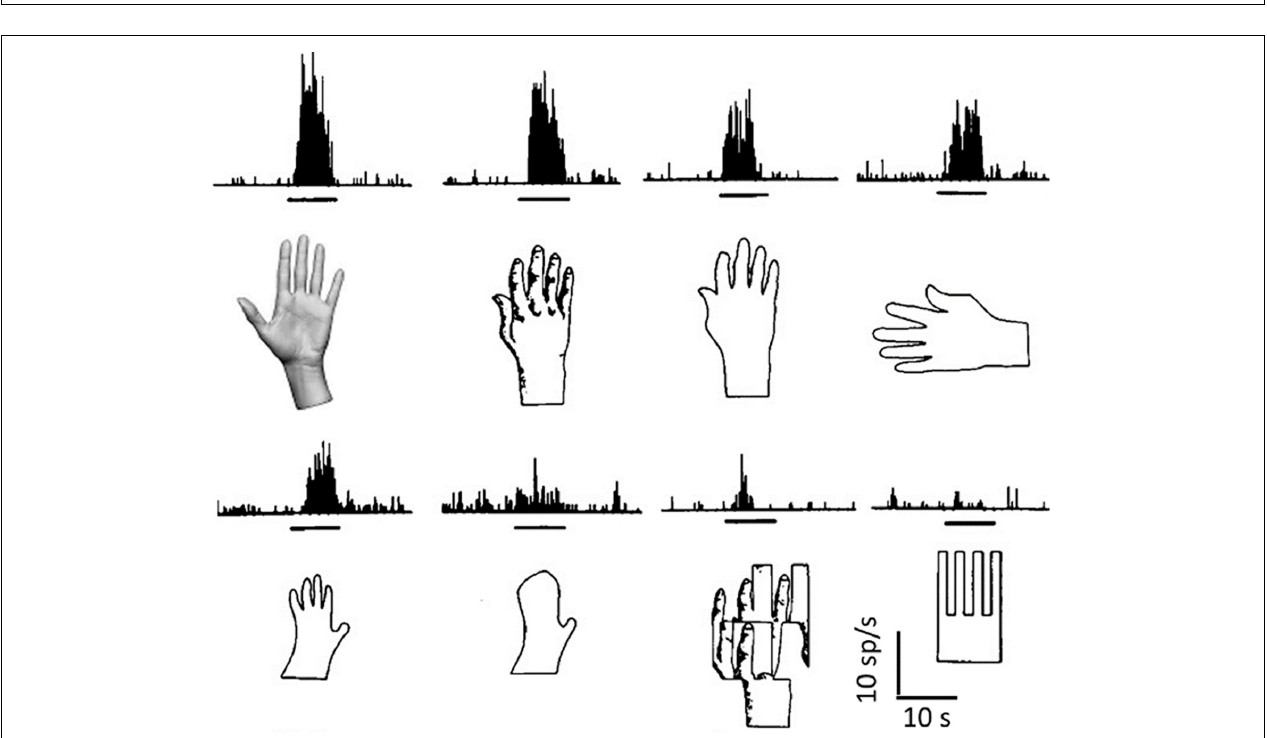
FIGURE 2 | Object recognition by a single neuron. Responses (histograms of spike frequencies vs. time) of a single neuron to the corresponding images, presented during the times indicated by the horizontal black bars. Many different elaborations clearly converge onto this neuron, which does not recognize a pattern, but many possible visual patterns that can be related to the shape of a hand, through association and generalization, either in a pictorial or in a structural way (elements and their relations). Object detection is tentative, and the discharge rate indicates the likelihood that what is being seen belongs to a certain conceptual category. Modified from Gross et al.